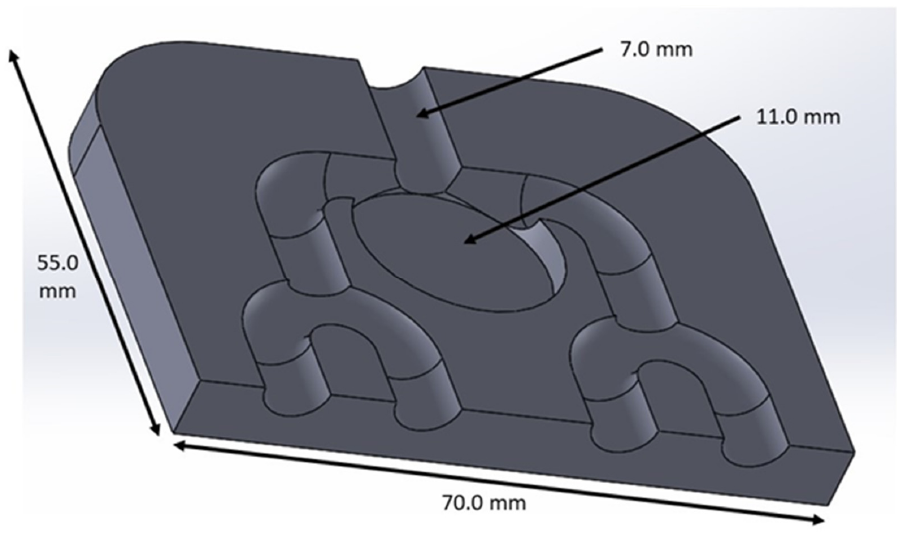
Figure 3. Illustration of one of the halves of the lung for the Cascade System for Biomineralization in Cement.